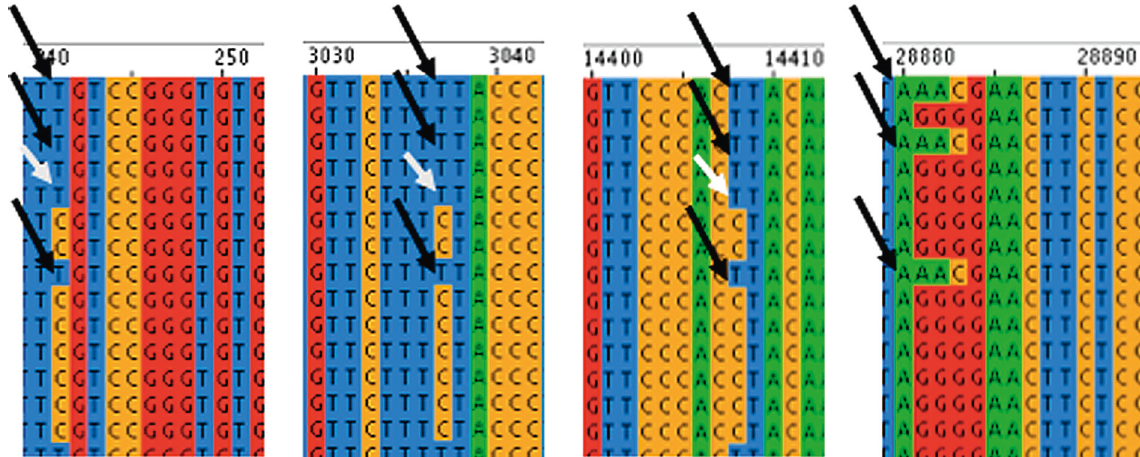
Figure 1: GGG > AAC change in SARS-CoV-2 is always accompanied by three other C > T mutations in positions 241, 3037, and 14408 of the virus genome as indicated by black arrows. However, C > T change in these positions does not always mean the presence in GGG > AAC as indicated by white arrows. All positions are aligned to the NCBI SARS-CoV-2 reference